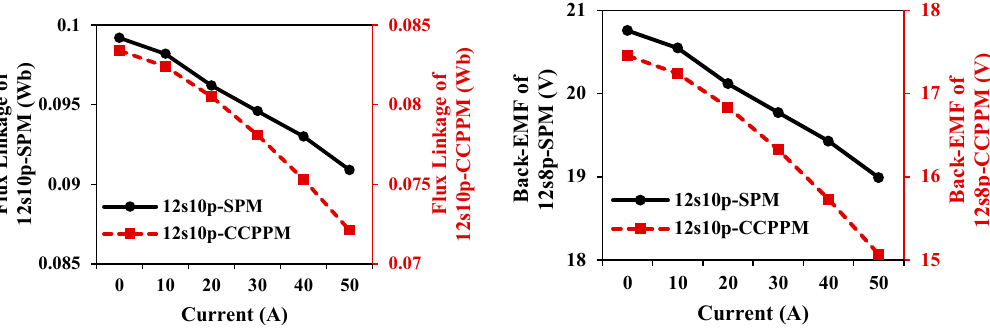
Figure 11. Amplitudes of fundamental harmonics in phase-A for 12s10p machines.